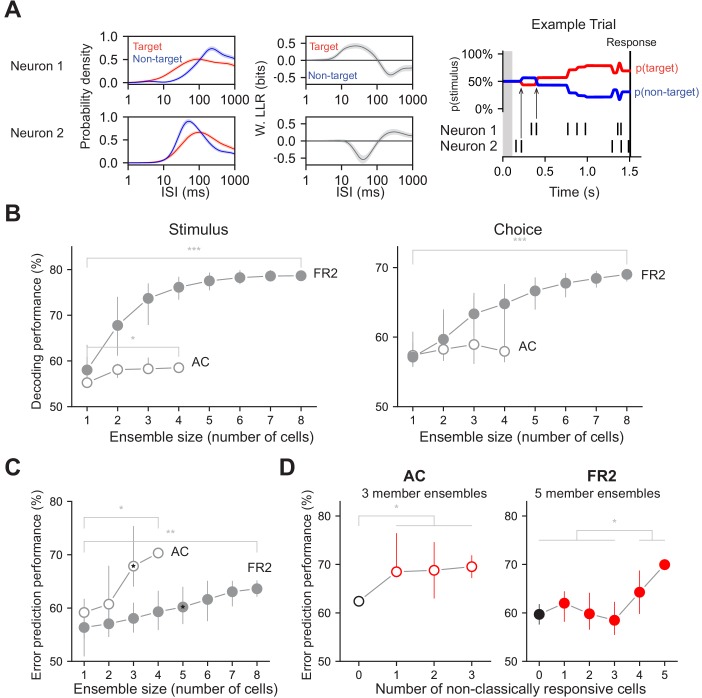
Decoding performance of neuronal ensembles recorded in AC or FR2.(A) Schematic of ensemble decoding. Left, conditional ISI distributions and corresponding weighted LLR shown for two simultaneously recorded neurons. Right, an example trial where each neuron’s ISIs and LLRs are used to independently update stimulus category according to Bayes’ rule. Arrows indicate the first updates from each neuron. (B) Stimulus and choice decoding performance for ensembles in AC and FR2 for ensembles of increasing size (Comparing smallest with largest ensembles. Stimulus: *pAC = 0.04, ***pFR2 = 1 × 10−5, Choice: pAC = 0.29, ***pFR2 = 7 × 10−5, Mann-Whitney U test, two-sided). (C) Error prediction performance in AC and FR2 as a function of ensemble size (*pAC = 0.03, **pFR2 = 0.002; comparison between AC and FR2, for 3-member ensembles: p=1.2 × 10−5, for 4-member ensembles: p=0.03, Mann-Whitney U test, two-sided). Chance performance is 50%. (D) Error prediction performance in AC and FR2 as a function of the number of non-classically responsive cells in the ensemble (*pAC = 0.037, Welch’s t-test with Bonferroni correction for multiple comparisons; *pFR2 = 0.015, Student’s t-test with Bonferroni correction), 3 and 5 member ensembles in c. shown for AC and FR2 respectively. Chance performance is 50%.